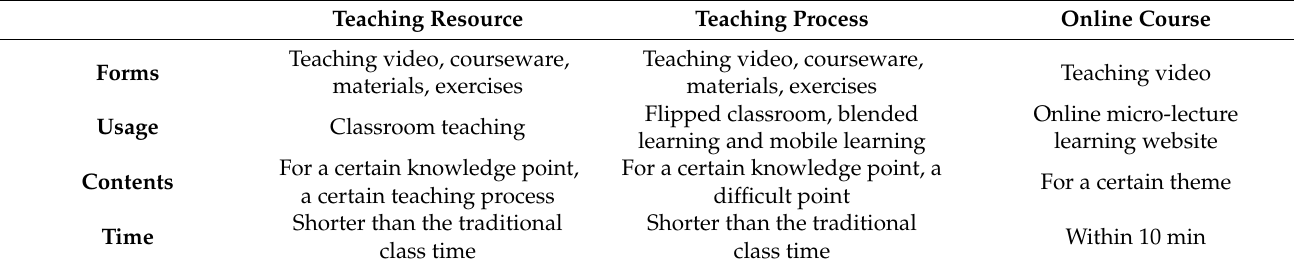
Table 2. Development phase of micro-lecture